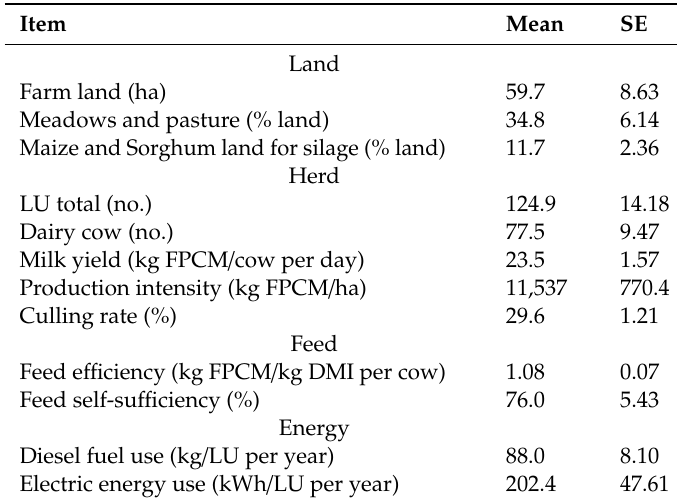
Table 1. Main characteristics of dairy farms (n =